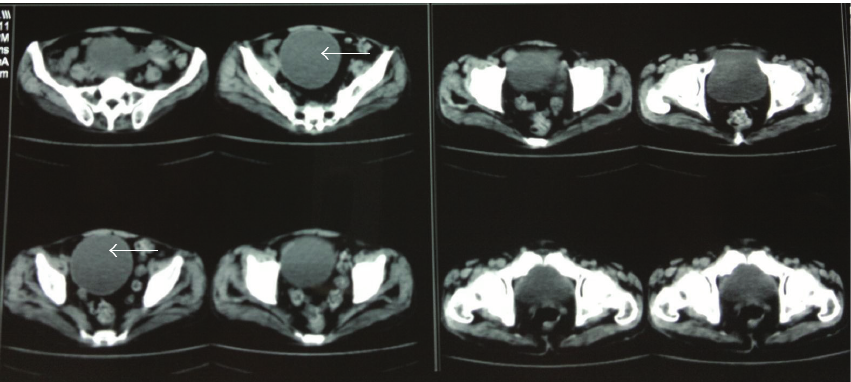
Figure 1: CECT of the pelvis shows solitary well-defined cystic lesion with clear fluid (WHO type CL) in pelvis.